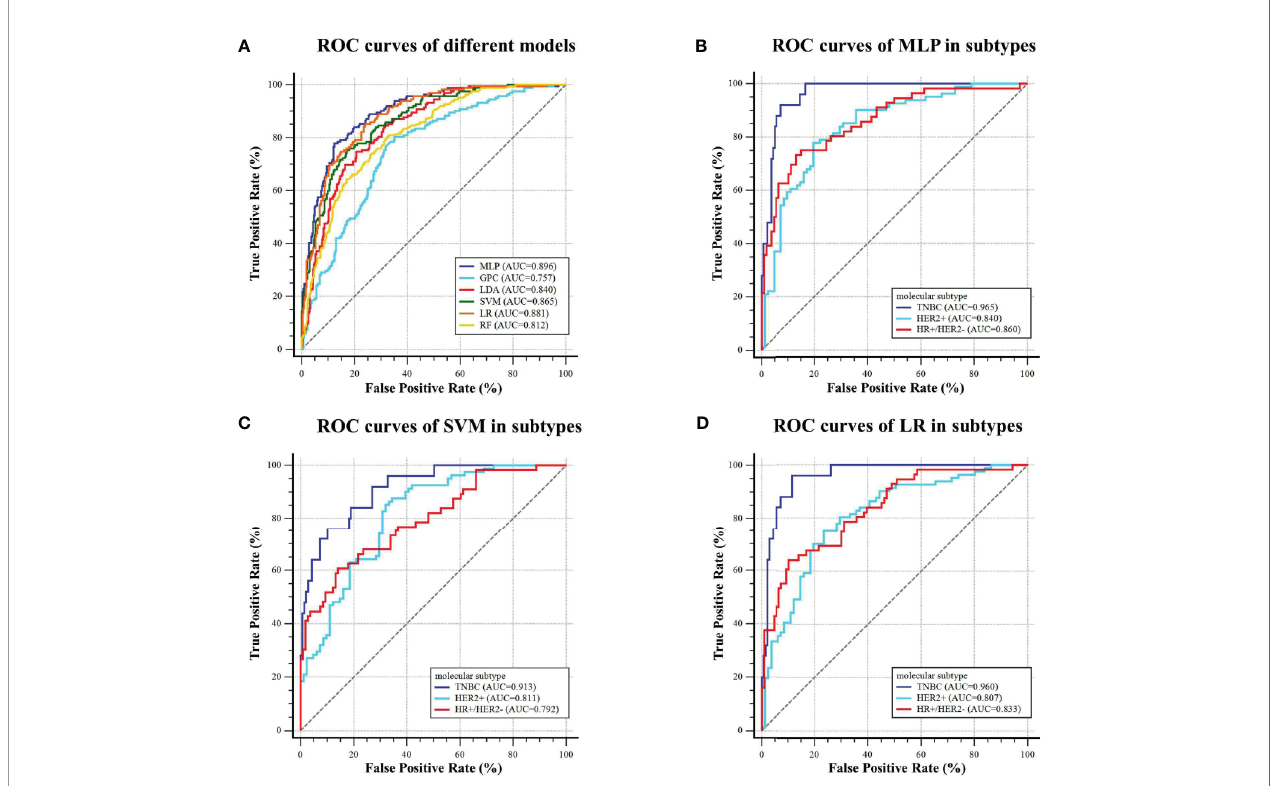
FIGURE 5 | ROC curves of the models predicting molecular subtype on the testing dataset. (A) Six machine learning classi fi ers were utilized for predictive model construction and their AUCs; (B – D) ROC curve of MLP, SVM, and LR in classifying TNBC and non-TNBC, HER2+ and HER2 − , and HR+/HER2 − and others, respectively.